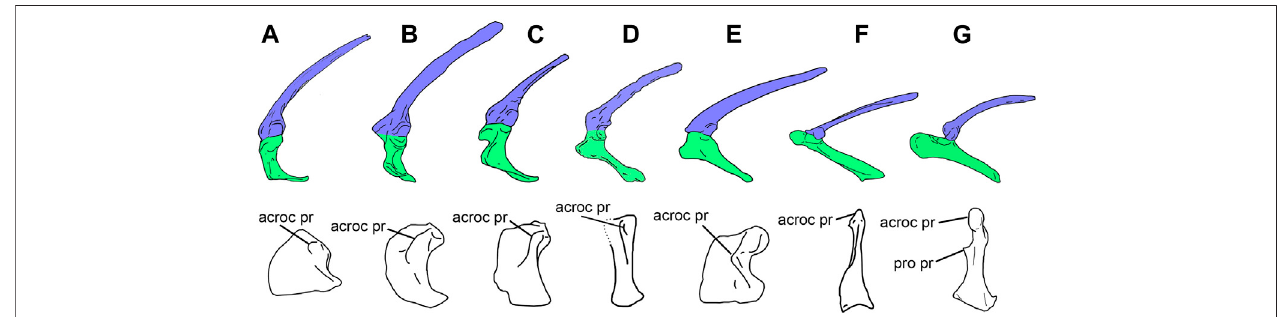
FIGURE 6 | Selected scapulocoracoids and coracoids from the left side in lateral (top) and anterolateral (bottom) views, showing variation in shape among basal paravians. (A) , Anchiornis huxleyi (Pei et al., 2017); (B) , Archaeopteryx lithographica (London specimen); (C) , Buitreraptor gonzalezorum ; (D) , Confuciusornis sanctus (Chiappe and Meng, 2016; the anterolateral view is distorted in the original specimen, and thus, its reconstruction is uncertain); (E) , Sapeornis chaoyangensis ; (F) , Enantiornithine bird (modi fi ed from Mayr, 2017); (G) , Vultur gryphus . Scapula shaded in blue, coracoid shaded in green. Abbreviations. acroc pr, acrocoracoid process; pro pr, procoracoid process. Not to scale.